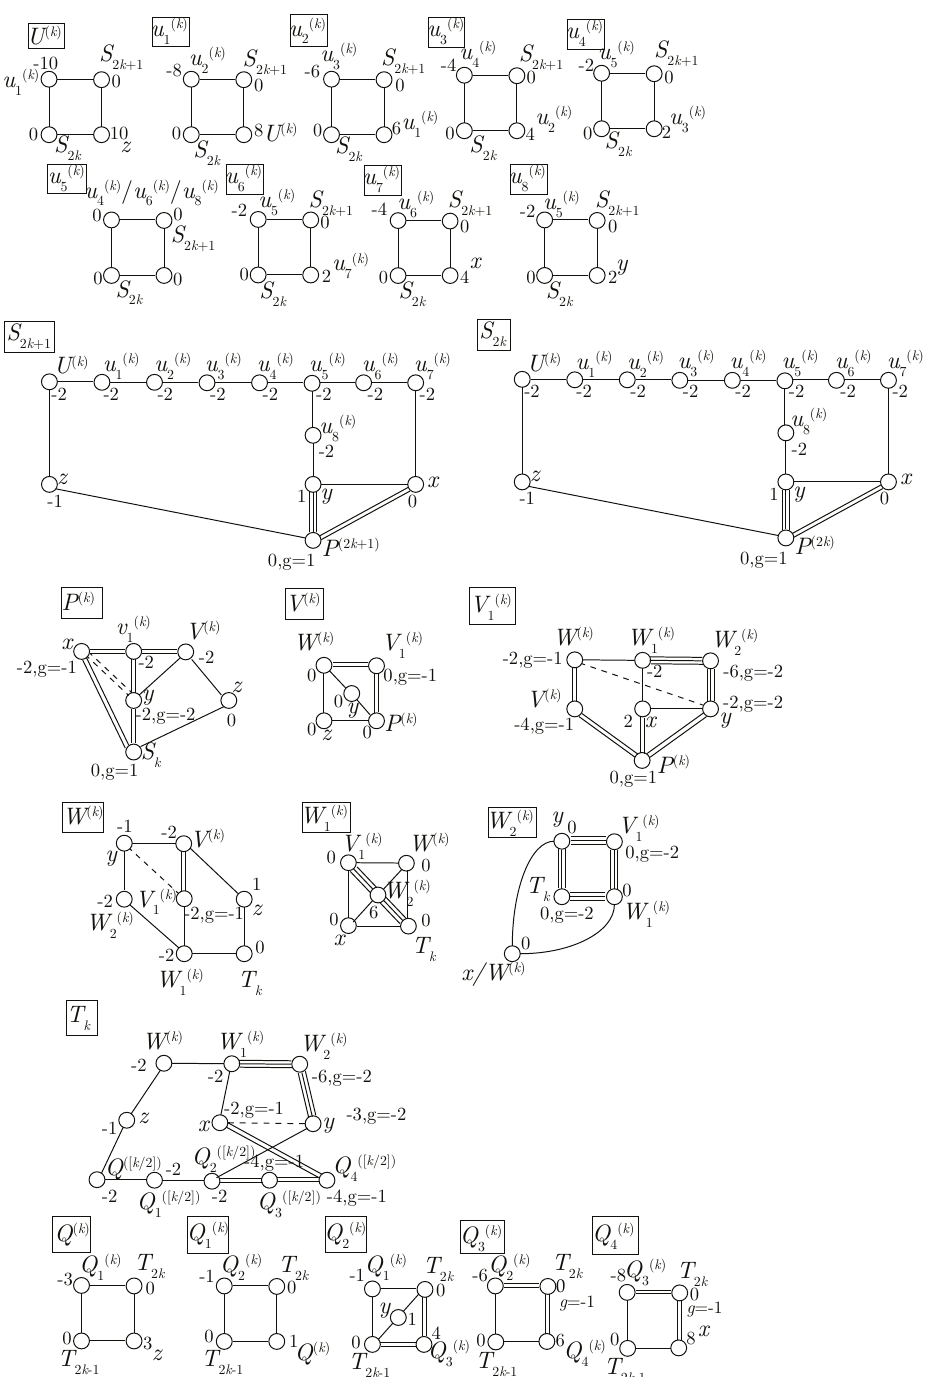
Figure 13. The con(cid:12)guration of curves in the KK resolution geometry of non-minimal ( E 8 ; E 8 ) conformal matter with order N . \[]" means the rounded up integer value. Dotted line means negative intersection number.